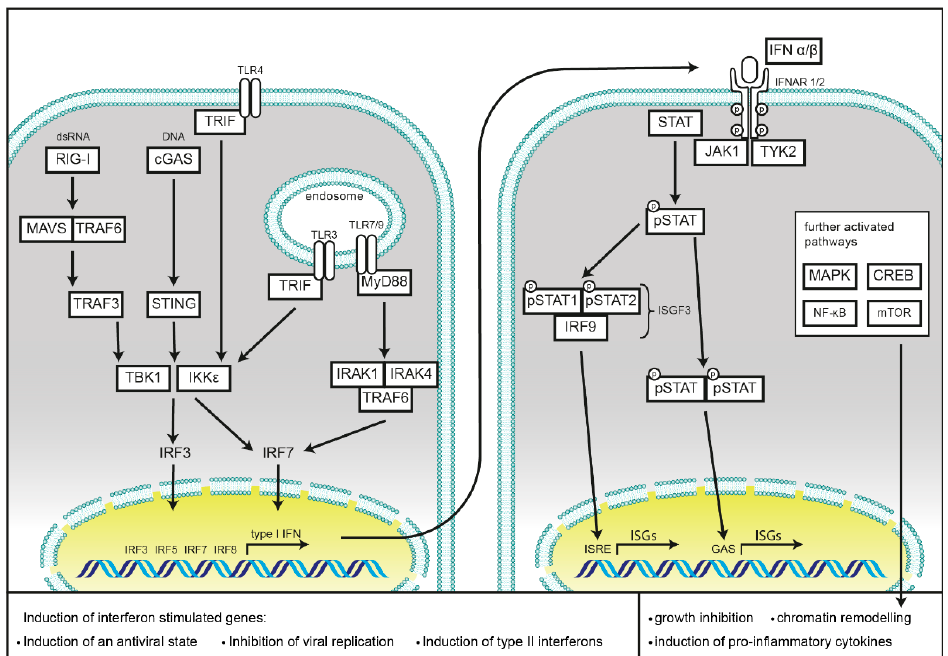
Figure 1. Schematic representation of cellular type I interferon secretion. Induction pathways and the main components of interferon production (left) and type I interferon signaling (right) are